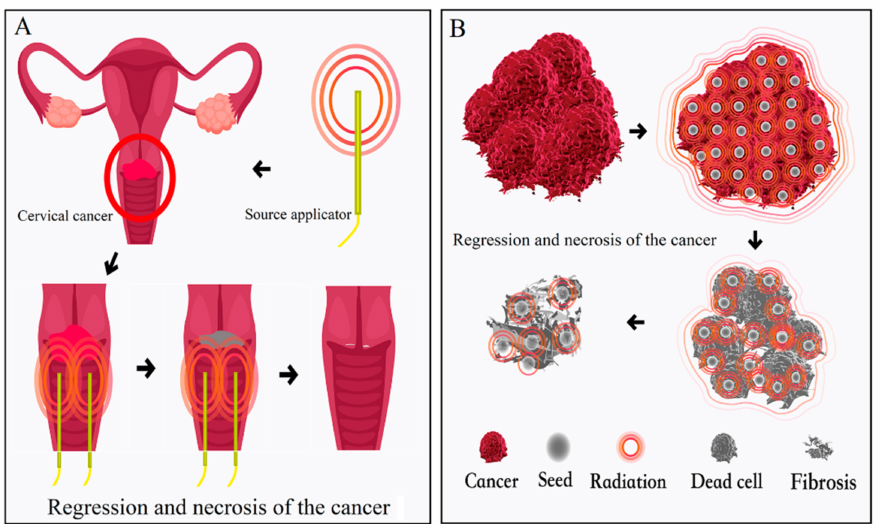
Figure 2. Stereotactic ablative brachytherapy (SABT) with high-prescribed radiation dose delivered to the tumor cell and tumor cell is directly ablated and replaced by fibrosis. ( A ): Intracavitary irradiation ( B ): Schematic process of cancer cell death after seed